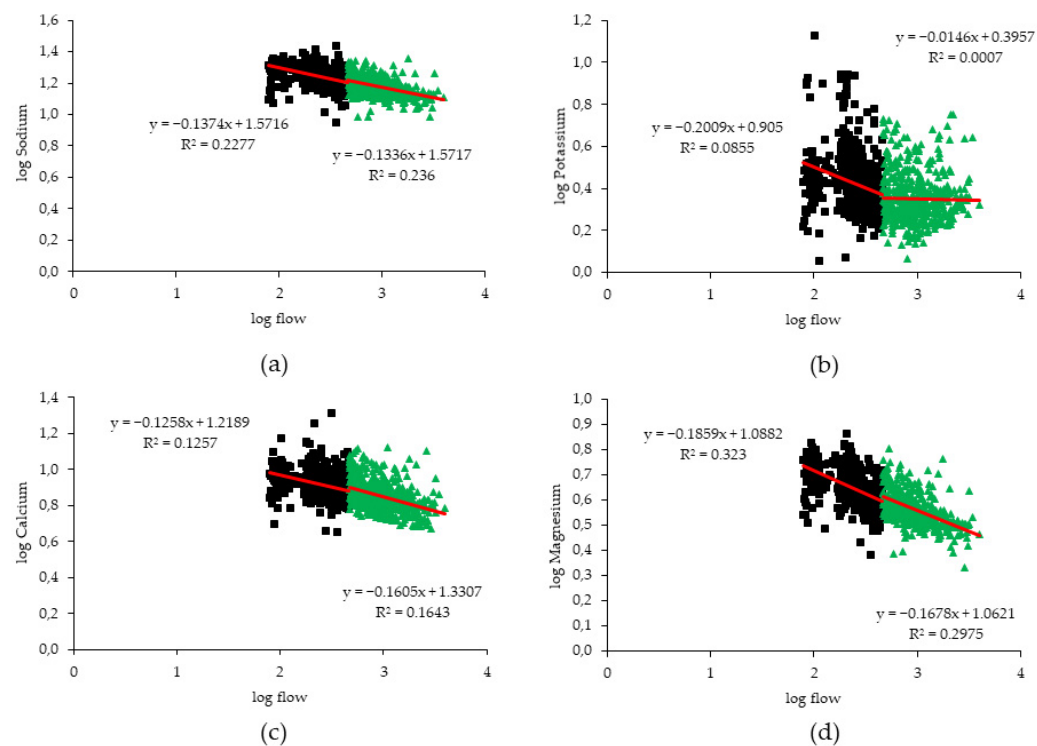
Figure 8. Log [concentration]–Log [discharge] plots for ( a ) sodium, ( b ) potassium, ( c ) calcium and ( d ) magnesium in the Valiñas catchment. Regression equations and coefficients are displayed separately for those data below and above the median flow.